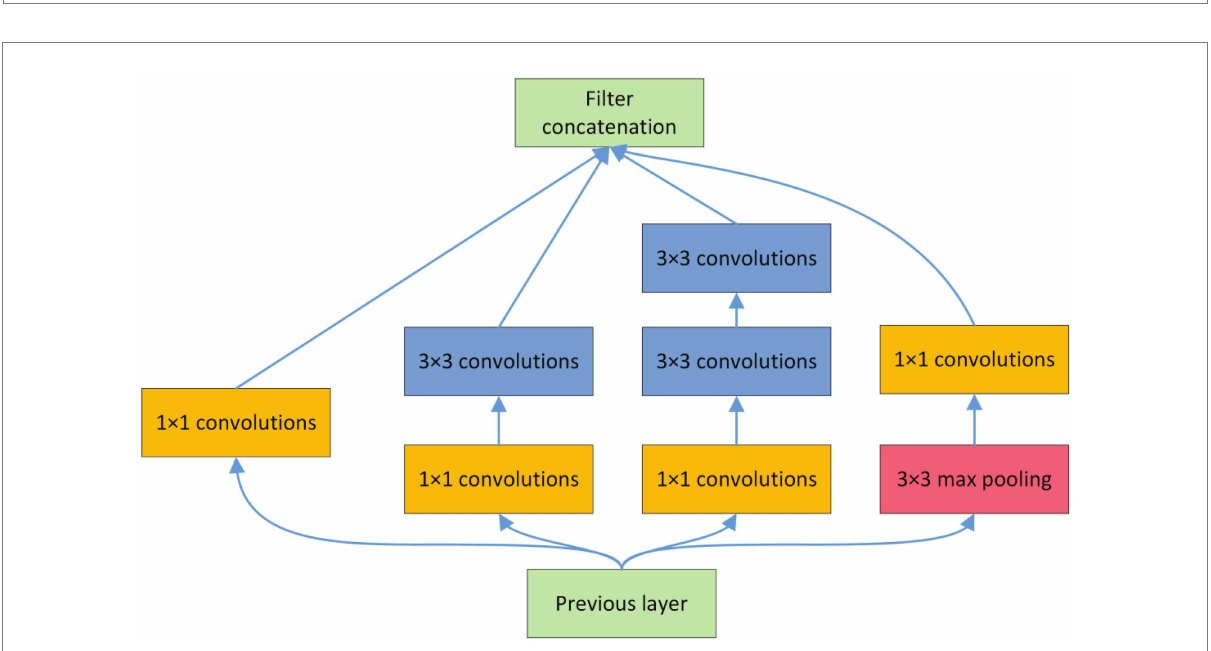
FIGURE 4 Structure of the inception module: (A) Training and validation loss; (B) Training and validation